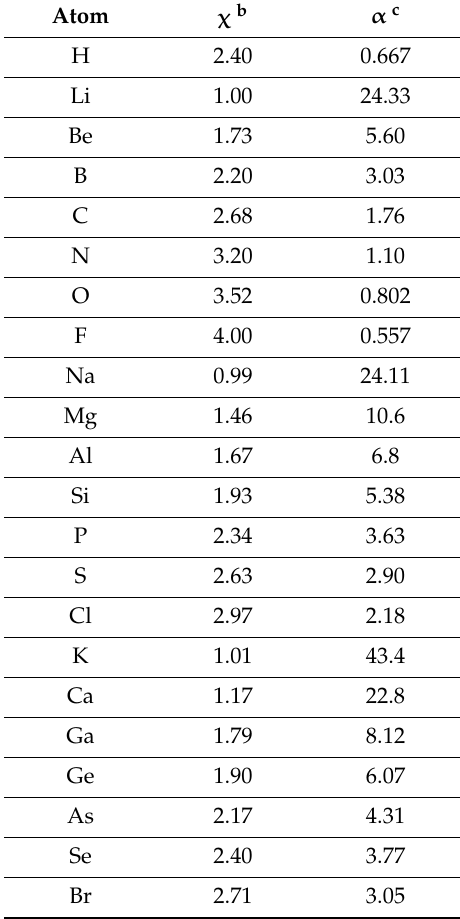
Table 2. Electronegativities χ and polarizabilities α of ground-state atoms a